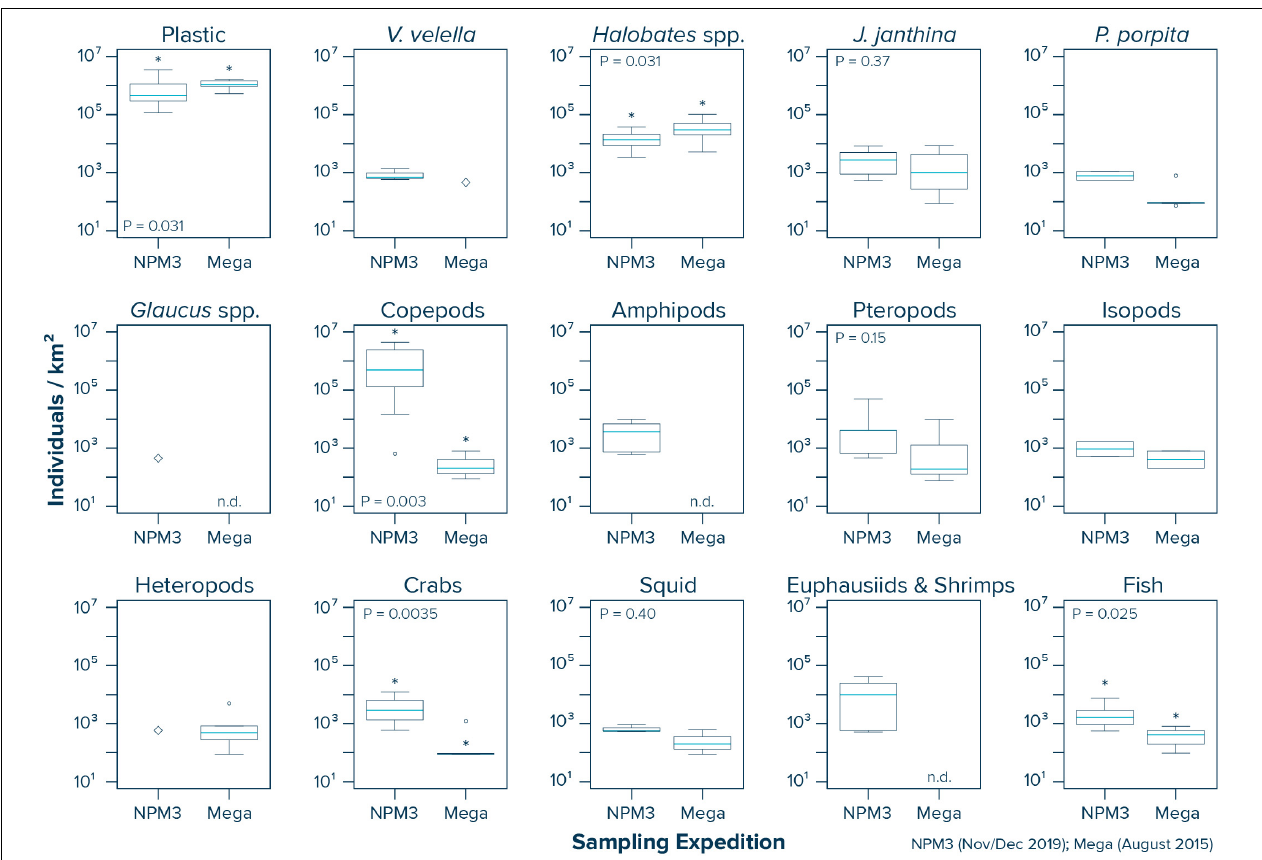
FIGURE 5 | Comparison of the observed plastic and species abundance inside the North Pacific Garbage Patch (Area C) during the NPM3 Expedition (November/December 2019; red circles in Figure 1 ) and the Mega Expedition (August 2015; green circles in Figure 1 ). Horizontal lines represent median values. Box plots extend from the 25th to the 75th percentiles, while whiskers extend from the minimum to the maximum observed values. Large diamonds indicate that the species was only present in one Manta trawl. Dots indicate outliers. Asterisk indicates a statistically significant ( P < 0.05; Wilcoxon–Mann–Whitney test) difference between the two sampling campaigns. n.d., not detected in any of the Manta